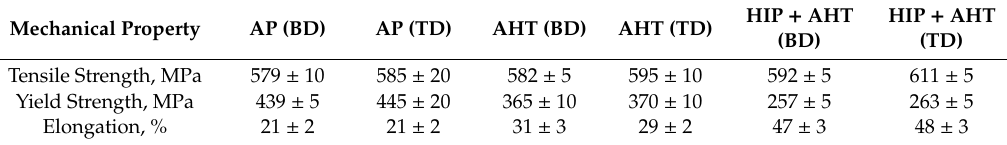
Figure 9. The engineering stress–strain curves of ( a ) the as-printed (AP) sample, ( b ) the AHT sample, and ( c ) the HIP + AHT sample. The stress–strain curves of each condition are compared in ( d ) the BD, and ( e ) the transverse direction (TD). Table 2. Summary of the mechanical properties of additively manufactured 316L stainless steel. (n = 5).